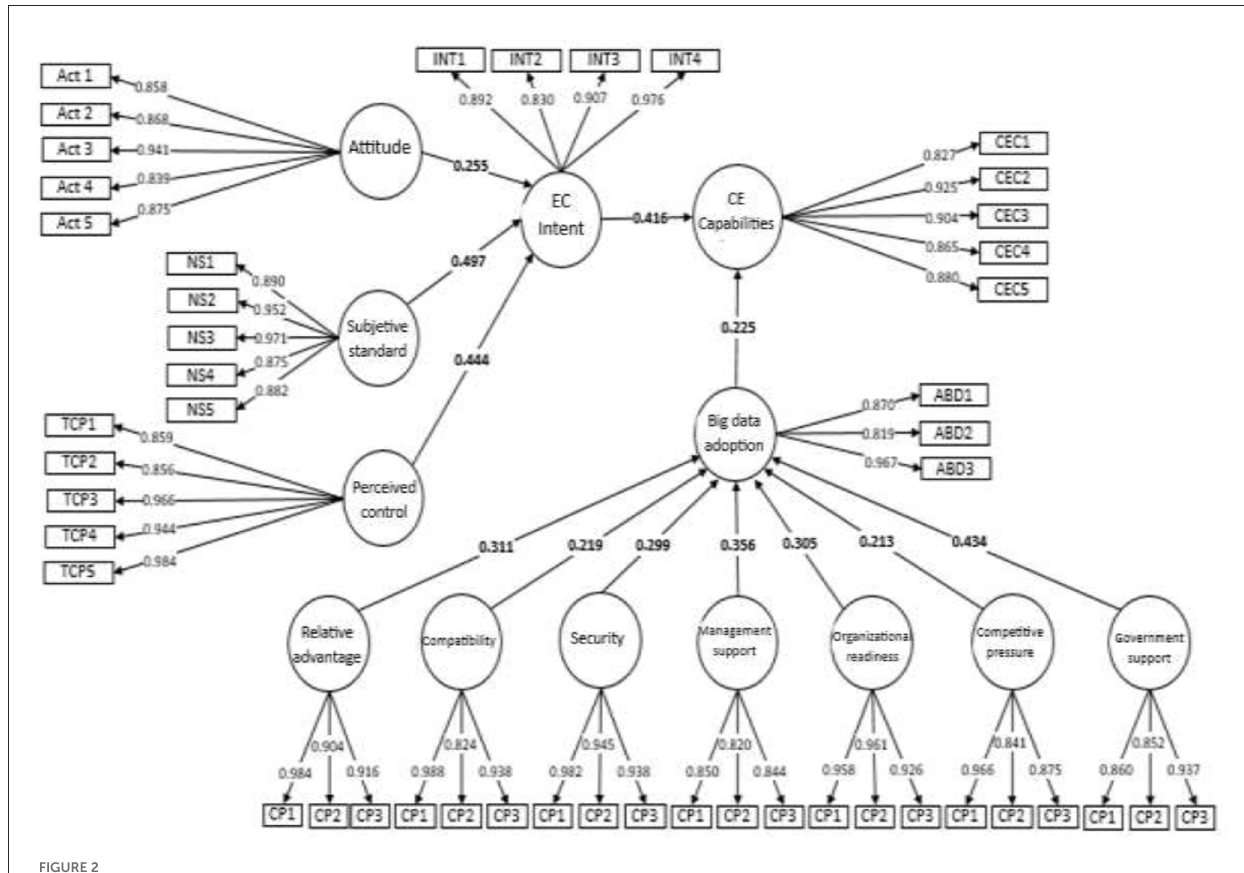
FIGURE2 Research model